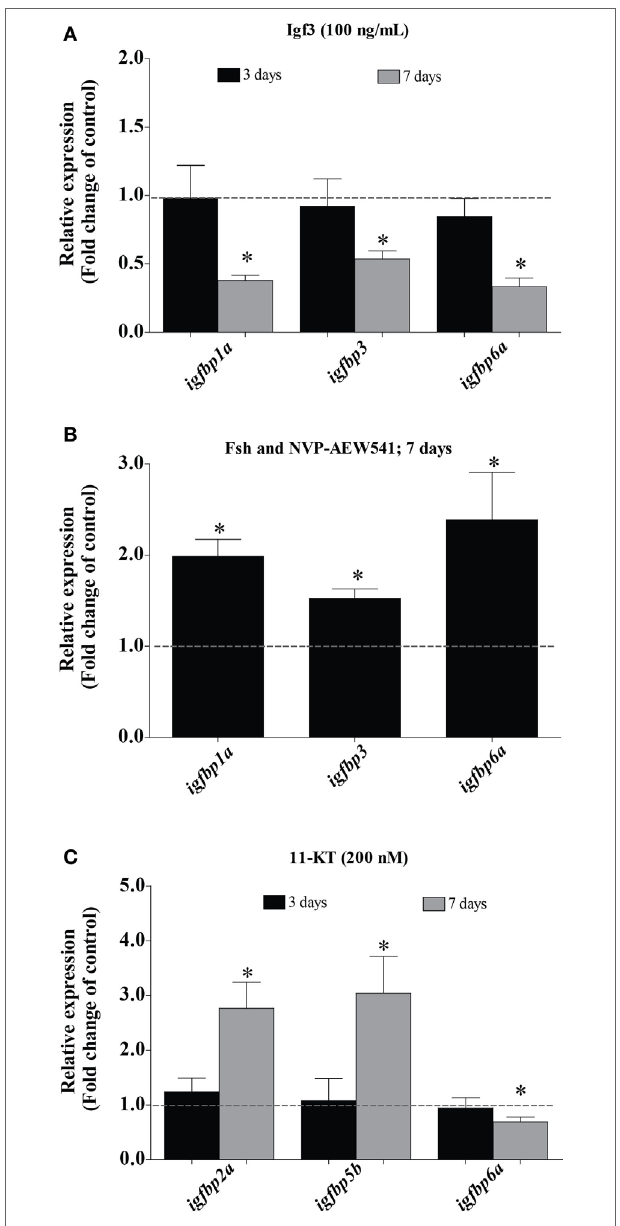
FigUre 3 | Effect of Igf3 and 11-KT on igfbp transcript levels in adult zebrafish testis. (a) Transcript levels of igfbp s in the presence of Igf3 (100 ng/mL) after 3 or 7 days of incubation ( n = 8). (b) Igfbp expression in response to follicle-stimulating hormone (Fsh; 100 ng/mL) in the absence or presence of Igf receptor inhibitor NVP-AEW541 (10 µM) after 7 days of incubation ( n = 8). (c) Transcript levels of igfbp s in basal conditions or in the presence of 11-KT (200 nM) after 3 ( n = 7) or 7 ( n = 6) days of incubation. Transcript levels of igfbp s are expressed as fold-change compared to the respective control condition (basal or 100 ng/mL Fsh) represented by a dotted line. Asterisks indicate significant differences (* P < 0.05) compared to the respective basal